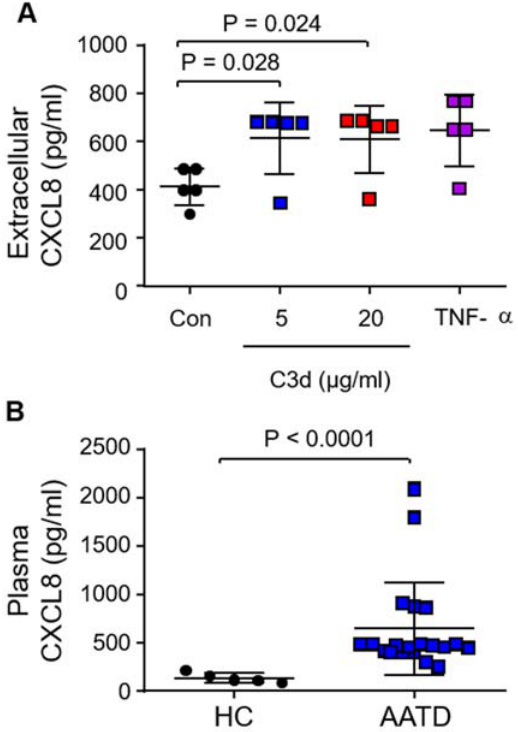
Figure 6. C3d induced secretion of pro-inflammatory CXCL8. ( A ) Extracellular supernatants of C3d- challenged HL-60 cells were analyzed by ELISA for the presence of CXCL8. C3d (5 µ g or 20 µ g/mL) treatment released significantly greater levels of CXCL8 when compared to control (Con) untreated cells ( p = 0.03, n = 5 independent experiments, ANOVA followed by Bonferroni post-hoc test for selected groups). ( B ) Levels of soluble CXCL8 were significantly higher in AATD plasma samples ( n = 25) when compared to healthy controls ( n = 7; HC) ( p < 0.0001, Student’s t -test). Measurements are mean ± SEM.